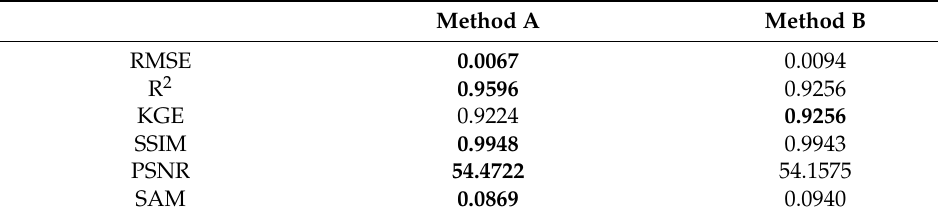
Table 5. Evaluation of cloud removal results of the whole scene image.